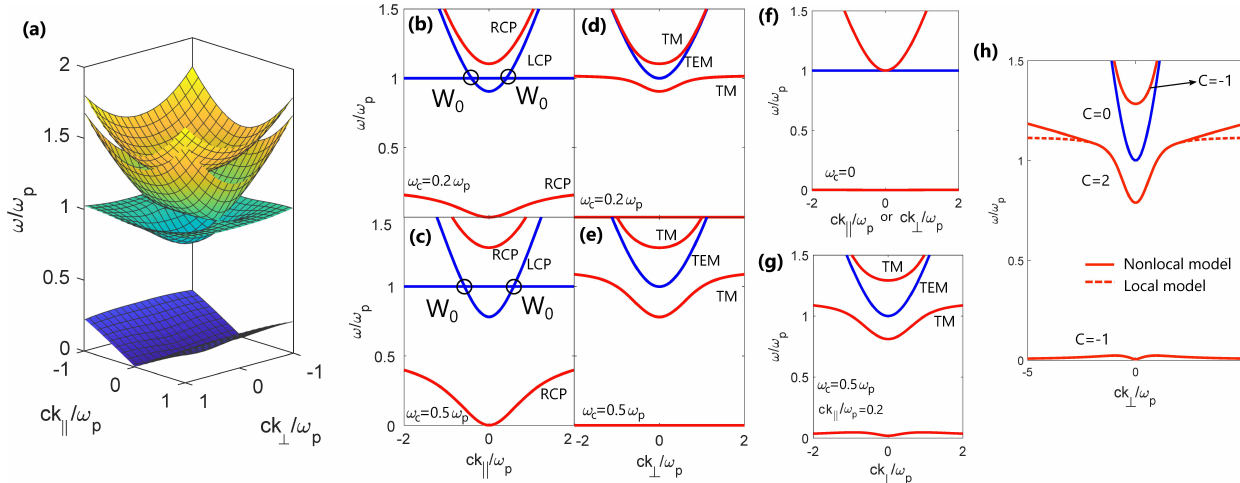
Figure 3. Bulk dispersion characteristics of a magnetized plasmonic material. ( a ) Dispersion surfaces calculated using a standard Drude model for a plasma with a magnetic bias with strength ω c = 0.5 ω p (warmer colors correspond to higher frequency). ( b – g ) Cross sections of the dispersion diagram in ( a ) for varying magnetic field strengths and directions. Weyl points are indicated as W 0 . ( h ) Dispersion curves for propagation perpendicular to the magnetic field, calculated using a hydrodynamic model and compared to the local Drude model. The topological Chern numbers are indicated next to each band. We have assumed a small non-zero momentum along the bias to ensure that the lowest band is clearly visible. In all the dispersion diagrams for propagation perpendicular to the bias, TM modes are indicated in red and TEM modes are indicated in blue.